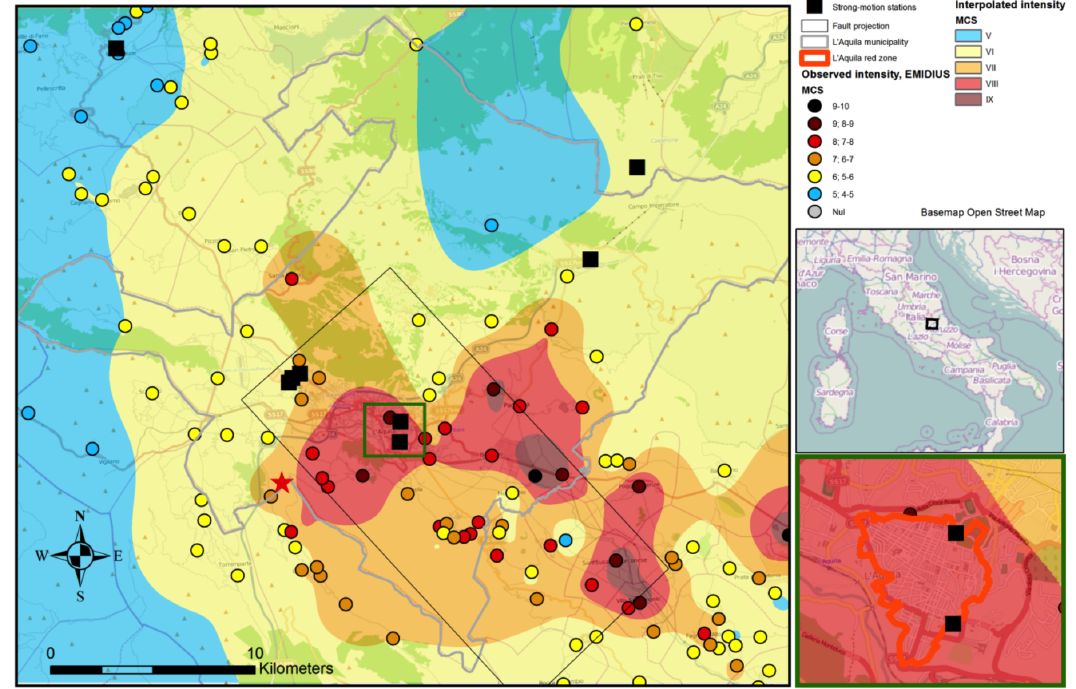
Figure 1. Interpolated macroseismic intensities using the intensities of Galli et al. [2009] reported in the DMBI-EMIDIUS database [Locati et al. 2011]. Isoseismals indicate the interpolated intensities whereas the observations are shown as colored